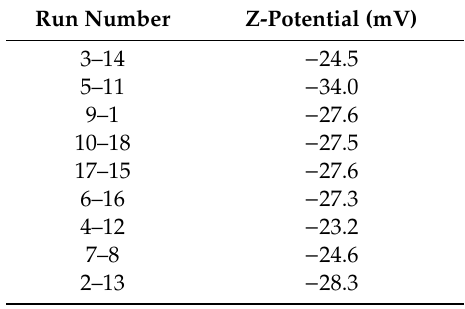
Table 4. ζ -potential of IBU nanocrystals in presence of Pharmacoat 603, after 60 min of